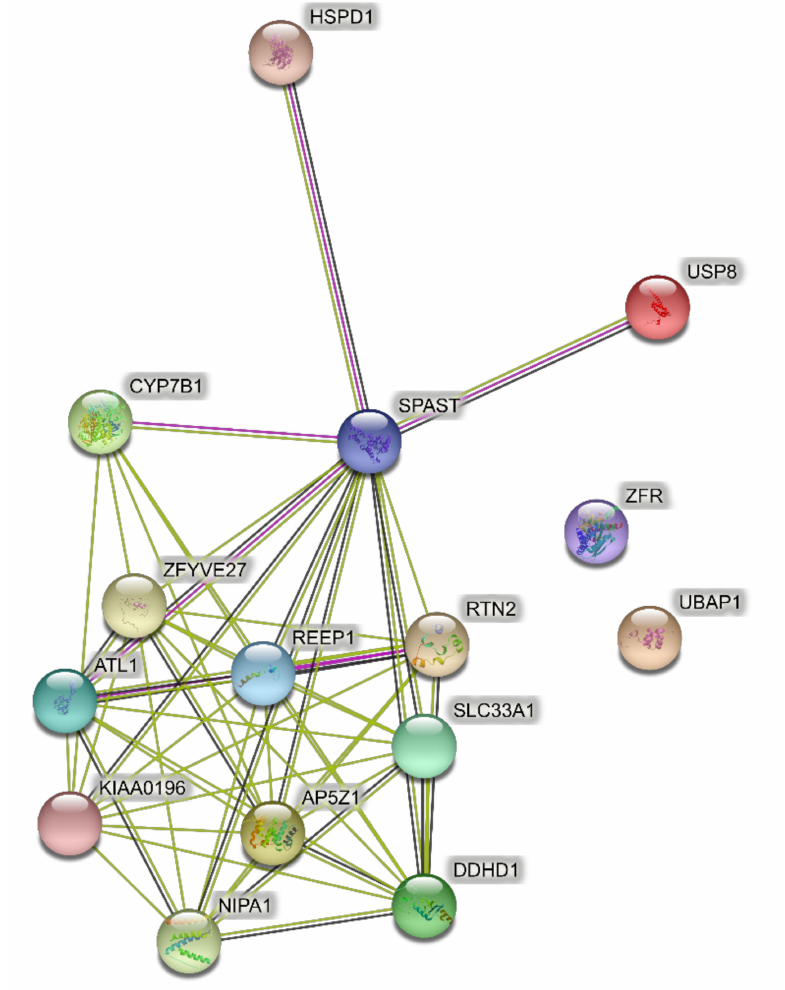
Figure 2. Predicted PPI networks for direct interactions among 15 genes of pure